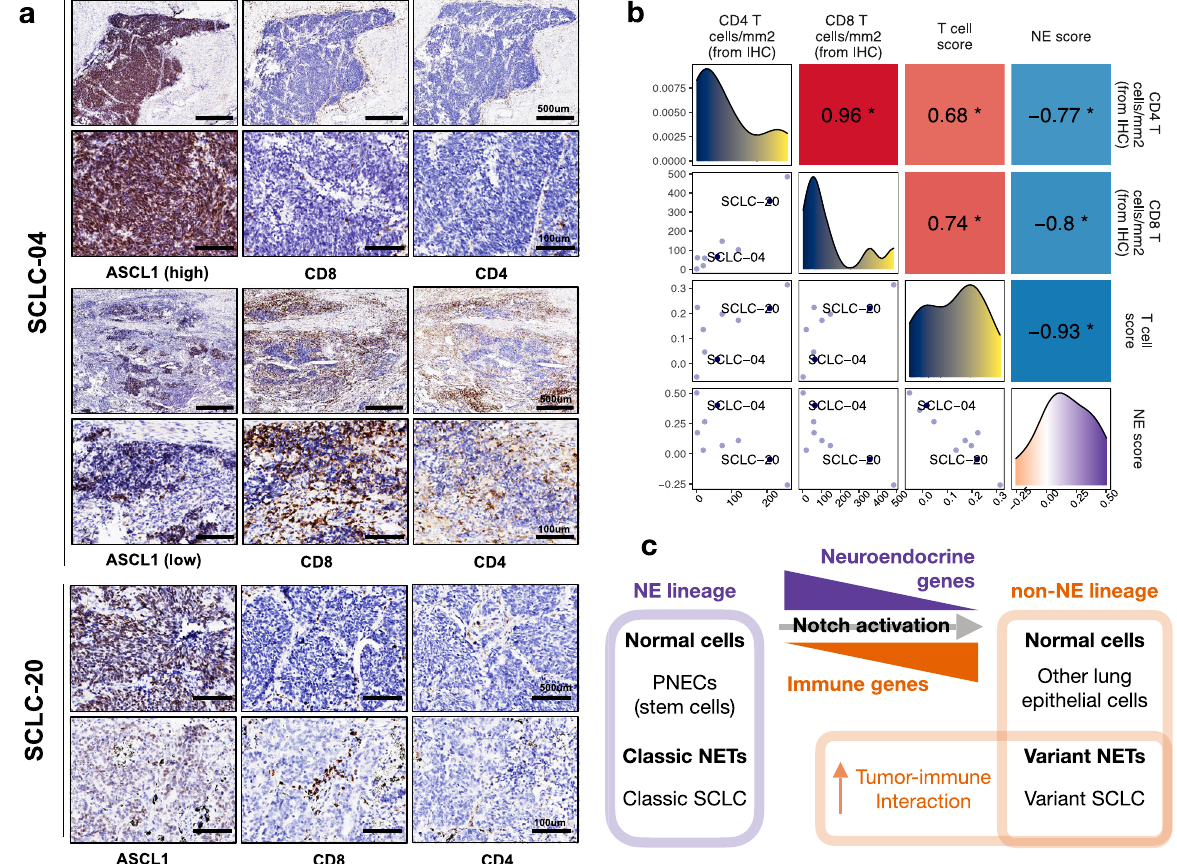
Fig. 4 Intertumoral and intratumoral heterogeneity in T cell in fi ltration from SCLC tumors with variable NE features. a IHC of ASCL1, CD4, and CD8 in selected tumors. SCLC-04 is an SCLC tumor with an NE score of 0.4. CD8 or CD4 T cells were few in the ASCL1-high regions but abundant in the ASCL1- low regions; SCLC-20 is a tumor with NE score of − 0.05, similar reciprocal relationship of ASCL1 staining and T cell in fi ltration was observed. Representative regions with high or low ASCL1 staining were shown. b Relationship between IHC-determined per area CD4 and CD8 T cell count, gene expression-based T cell score, and NE score in all nine tumors assessed. Lower left panels are scatter plots showing a pairwise relationship between variables, diagonal panels are density plots showing the distribution of each variable and upper right panels are correlation coef fi cients from pairwise Pearson correlation. * p -value < 0.05. T cell score was calculated by the ssGSEA method. c Schematic diagram showing a relationship between neuroendocrine and immune gene expression in normal cells and neuroendocrine tumors